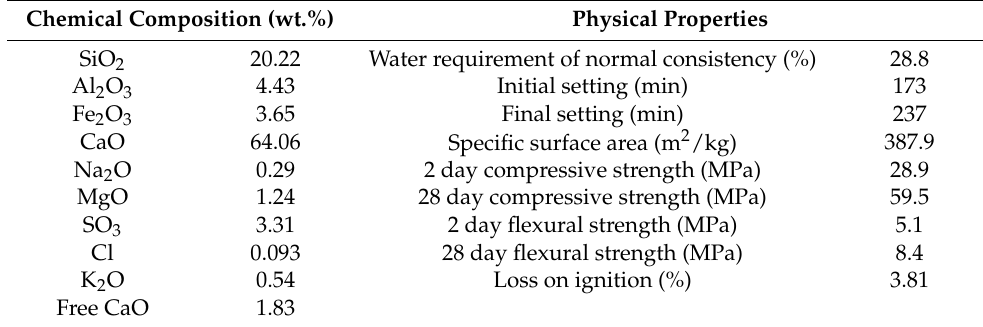
Table 1. Chemical composition and physical properties of cement. Chemical Composition